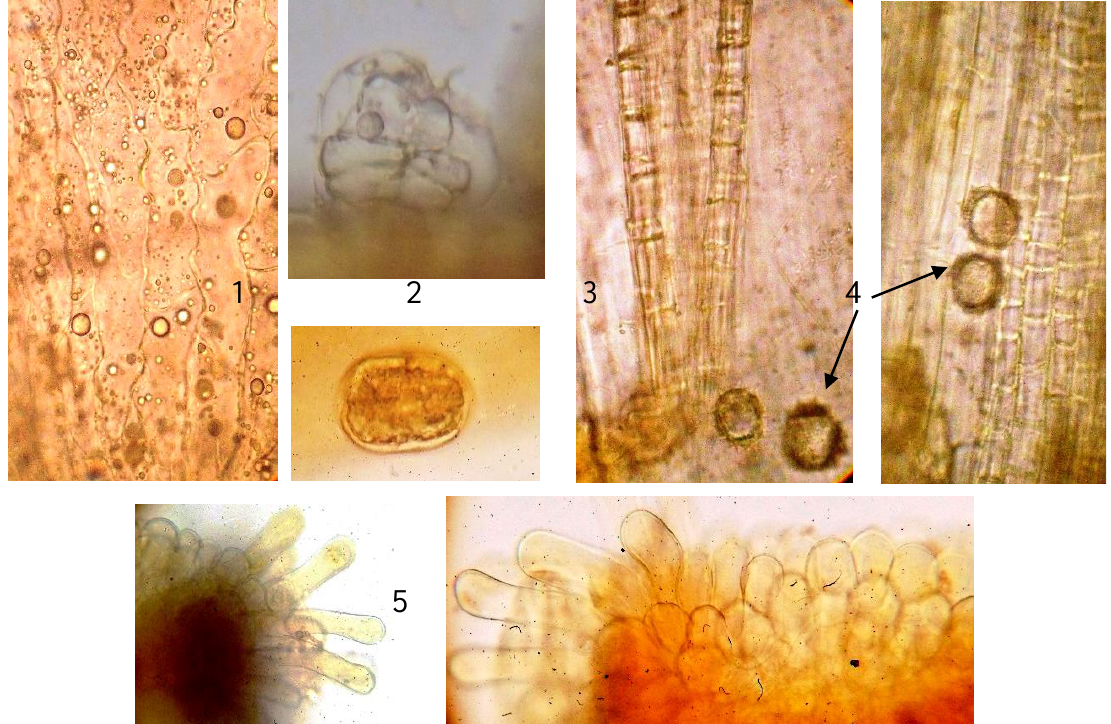
Fig. 5. Fragments of surface preparations of tubular flowers: 1 – epidermis of the limb; 2 – essential oil glands (side and top view); 3 – stamen filament; 4 – pollen grains; 5 – outgrowths of pistil style